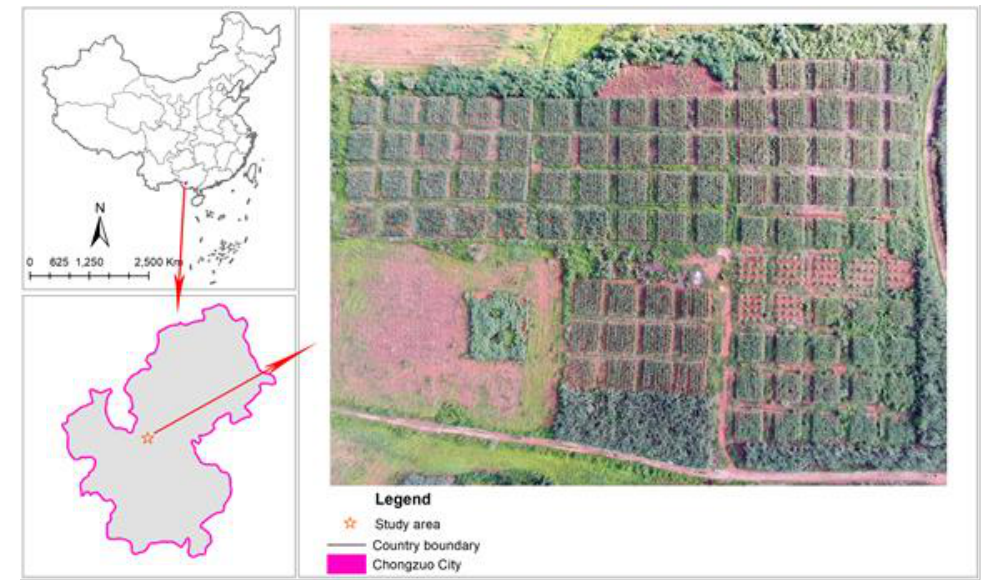
Figure 1. Location of the study site in Guangxi province, southern China, and the experimental sugarcane plot.